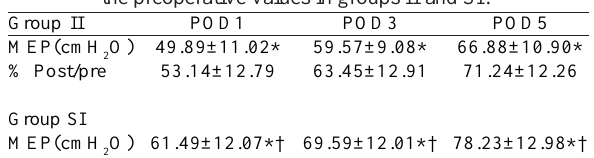
Table 3. Maximal expiratory pressure values are presented in 1, 3 and 5 PODs. Absolute values and as the percentage of the preoperative values in groups II and SI.